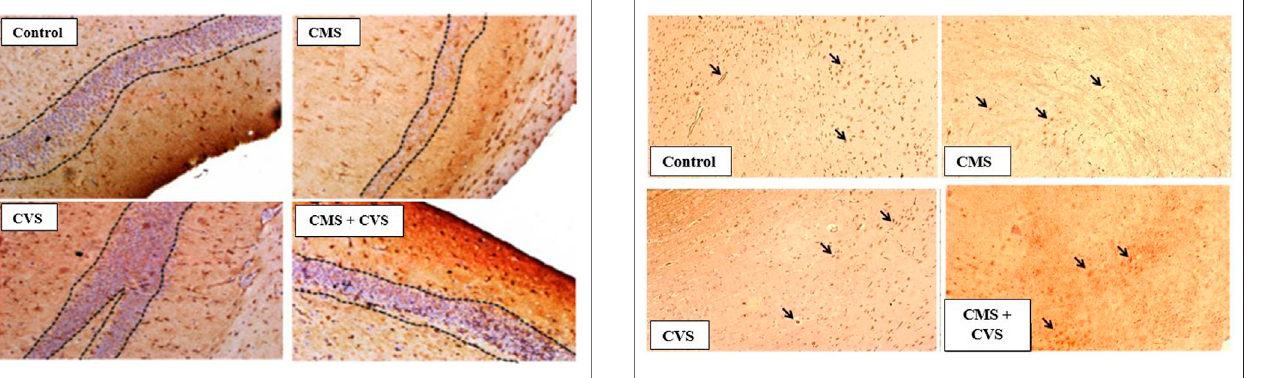
FIGURE 7 | Immunohistochemical staining for GDNF in rat hippocampus section. Shown are representative photomicrographs of different groups of rats. GDNF staining is prominently visible in the sections marked with arrows.